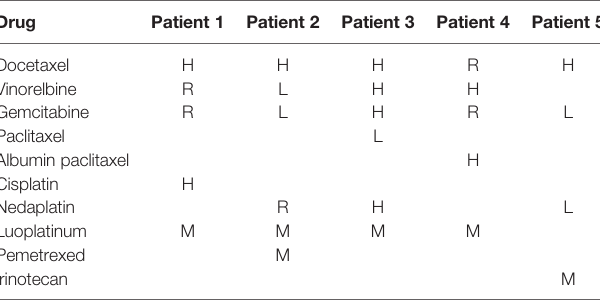
TABLE 4 | Drug susceptibility test results.